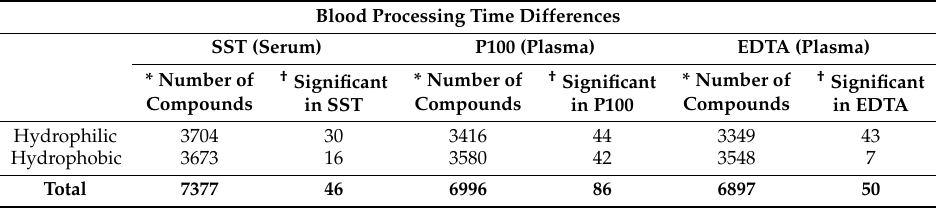
Table 1. Metabolites that changed with time in the collection tubes. Samples ( n = 3 subjects per time point for each tube) were collected on ice and placed in the refrigerator at 4 ◦ C to incubate. MS analysis was performed in positive ionization mode. * Number of compounds post-filtering (present in 50% of at least one tube type). † Differences among time points were identified using repeated measures ANOVA across all time points, adjusted for multiple testing using Benjamini Hochberg FDR ≤ 0.1.